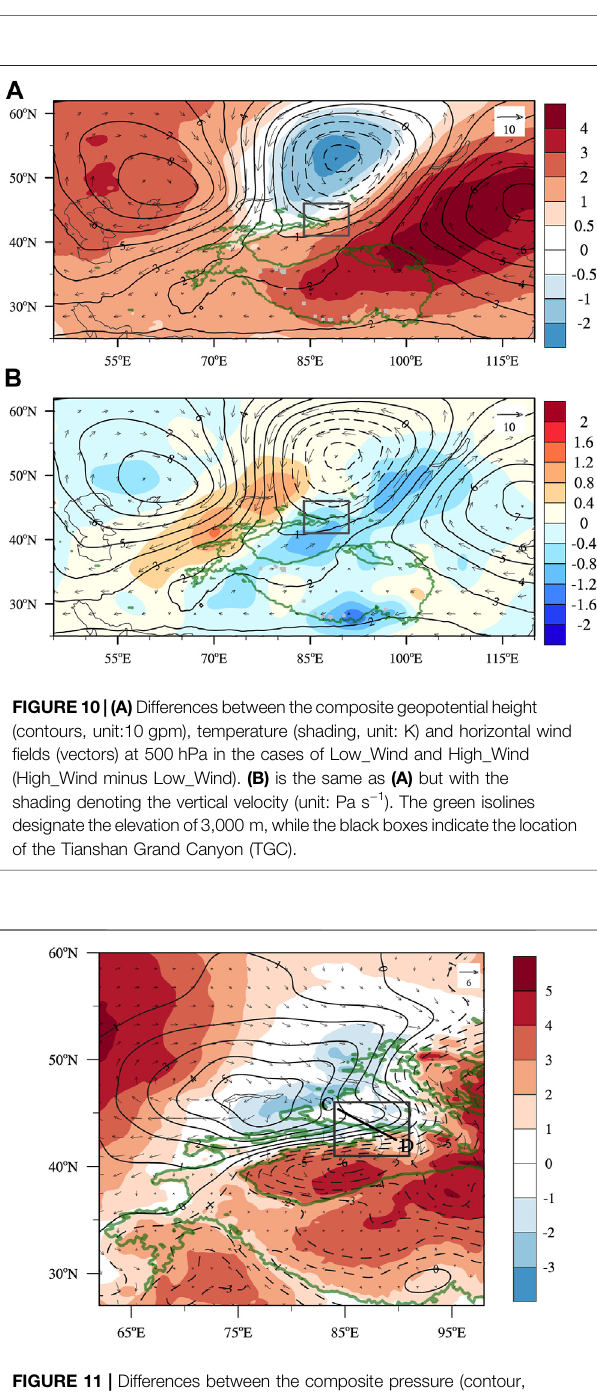
Frontiers in Earth Science |